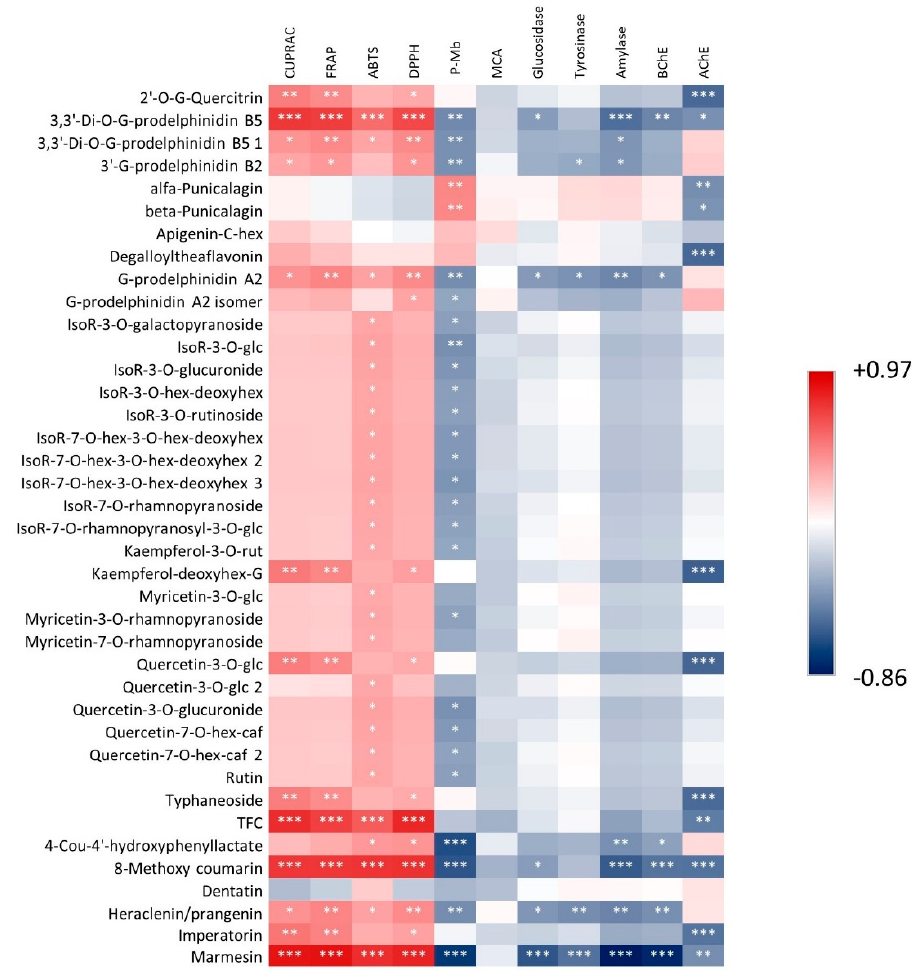
Figure 1. Correlation heatmap showing positive (red colour) and negative (blue colour) correlations between flavonoids and coumarins and measured bioactivities. Color scale is dependent on Pearson’s r value. Significance levels are indicated by asterisks in the plot. *: p < 0.05; **: p < 0.01; ***: p < 0.001. mentation problems [76]. The methanolic extract of P. meliocarpoides var. meliocarpoides displayed the best tyrosinase inhibitory effect (81.15 mg KAE/g), followed by P. uechtritzii (68.03 mg KAE/g) and P. heyniae (65.20 mg KAE/g). Aqueous extracts exhibited the